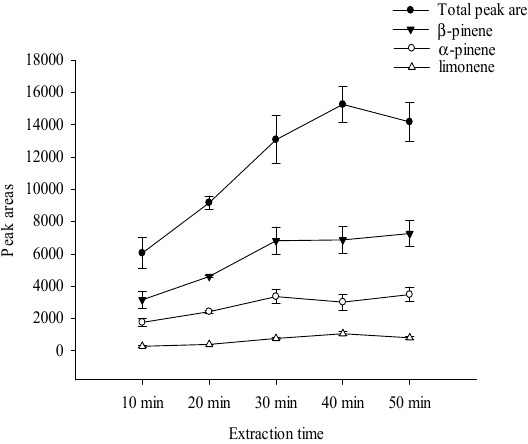
Figure 2. Comparisons of the peak areas of total volatile compounds and main components detected in the headspace of Nongshi No. 1 for different SPME extraction times at 25 °C using a DVB/CAR/PDMS fiber.